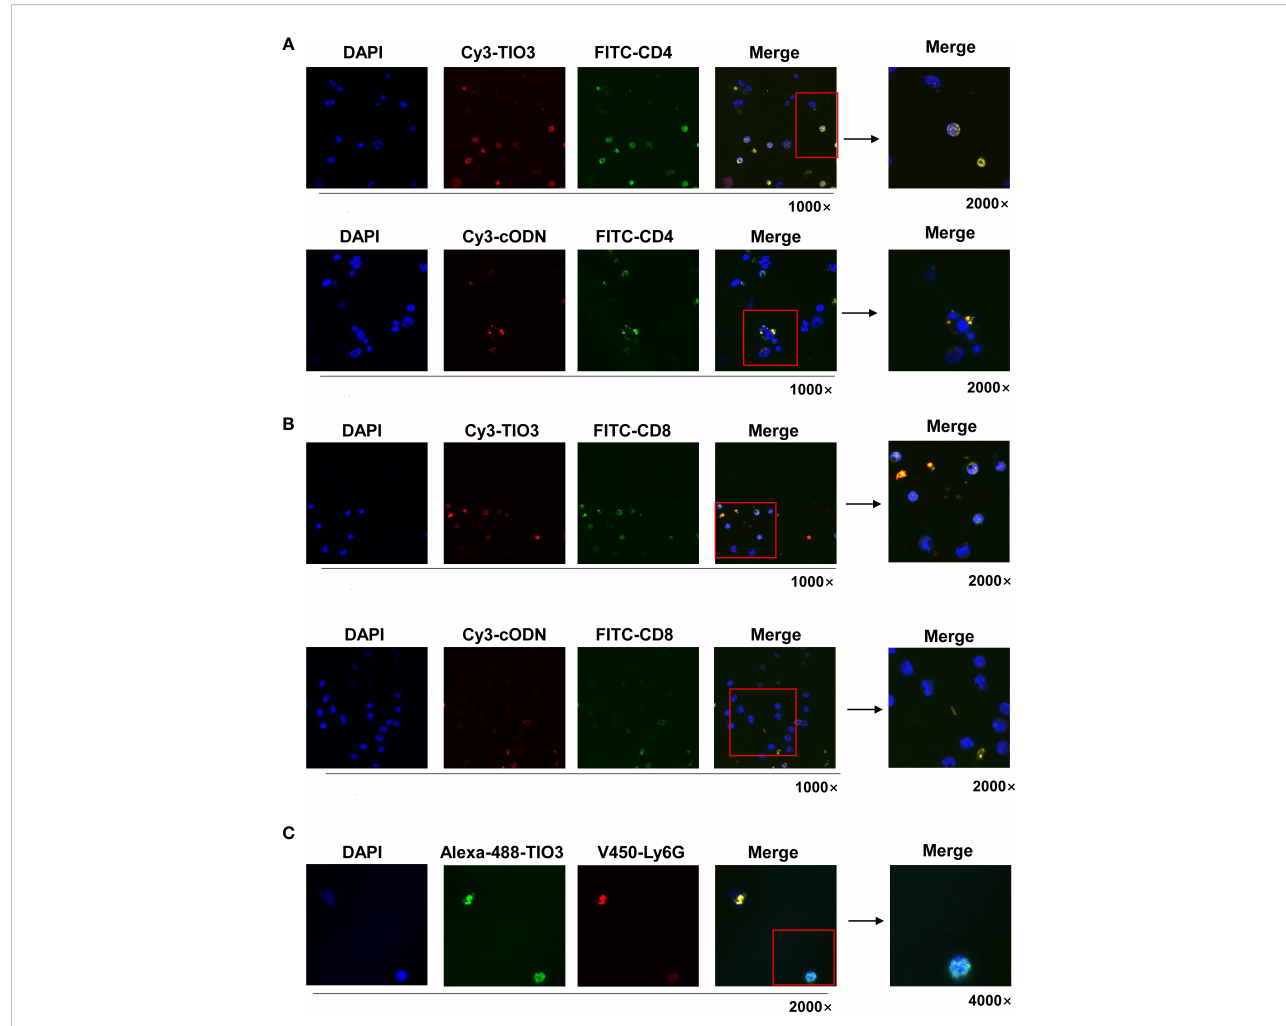
FIGURE 2 The TIO3 distribution in CD4 + T and CD8 + T cells. The lymph node (LN) cells from naive mice (n = 4) were incubated with red- fl uorescent Cy3-TIO3 or Cy3-cODN or with green- fl uorescent Alexa-488-TIO3 for 24 h, then stained with green- fl uorescent (FITC-labeled) mAbs against CD4 (A) or CD8 (B) or red- fl uorescent (V450-labeled) mAb against ly6G (C) , respectively, followed by counterstaining with DAPI, a blue fl uorescent DNA dye for staining the nucleus. The resultant cells were observed under the confocal microscope. (Magni fi cation, × 1000, × 2000, ×